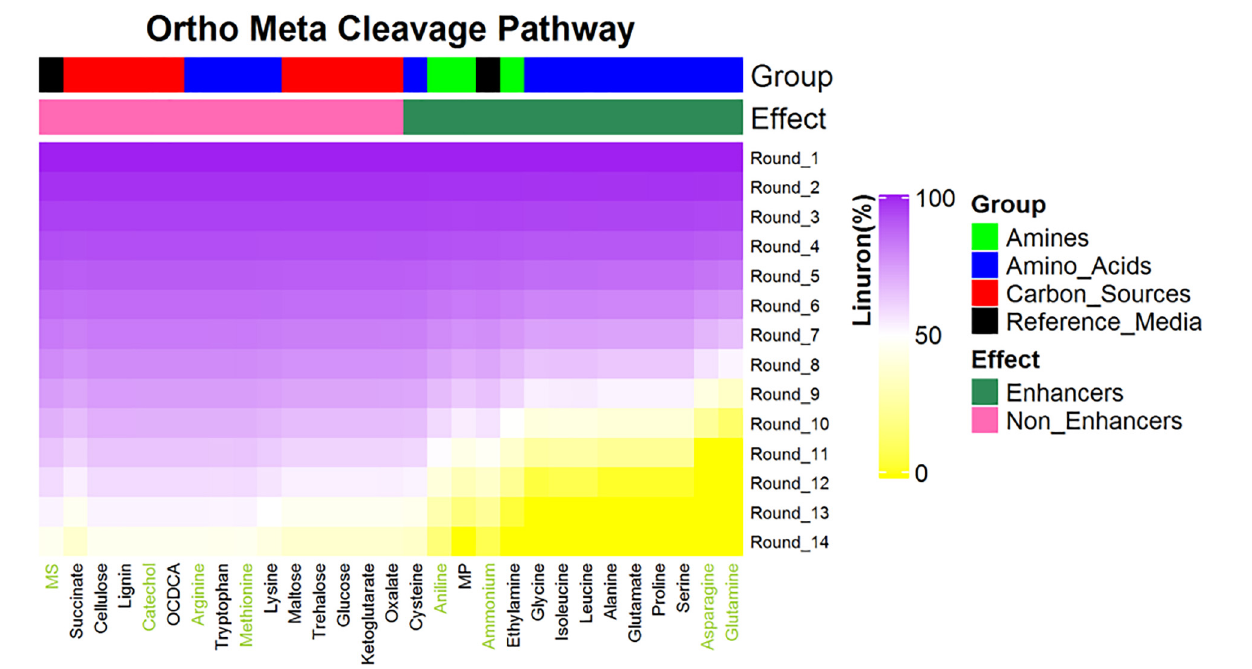
FIGURE 3 | Predictions for linuron degradation by SRS 16 in minimal media supplemented with linuron and 28 compounds (selected carbon and nitrogen sources). Compounds are ranked according the linuron amount in the ninth simulation rounds. All media contain linuron. Reference medium: MS = minimal solution + linuron + no supplement, MP = 2-methyl propanamine. A total of seven metabolites (green font) were selected for experimental validation. Simulations assuming Pathways 2 and 3; simulations assuming alternative pathways are provided in Supplementary File 7